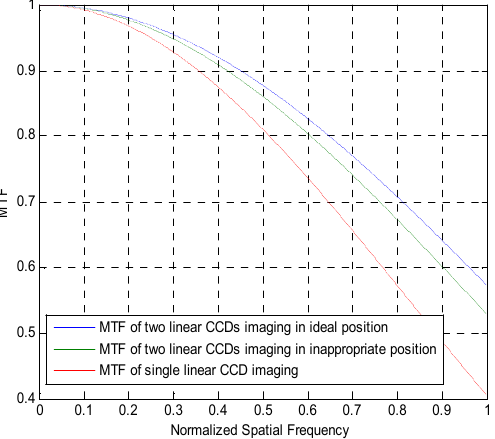
Figure 7. MTF comparison of single linear CCD and subpixel linear CCD pair.